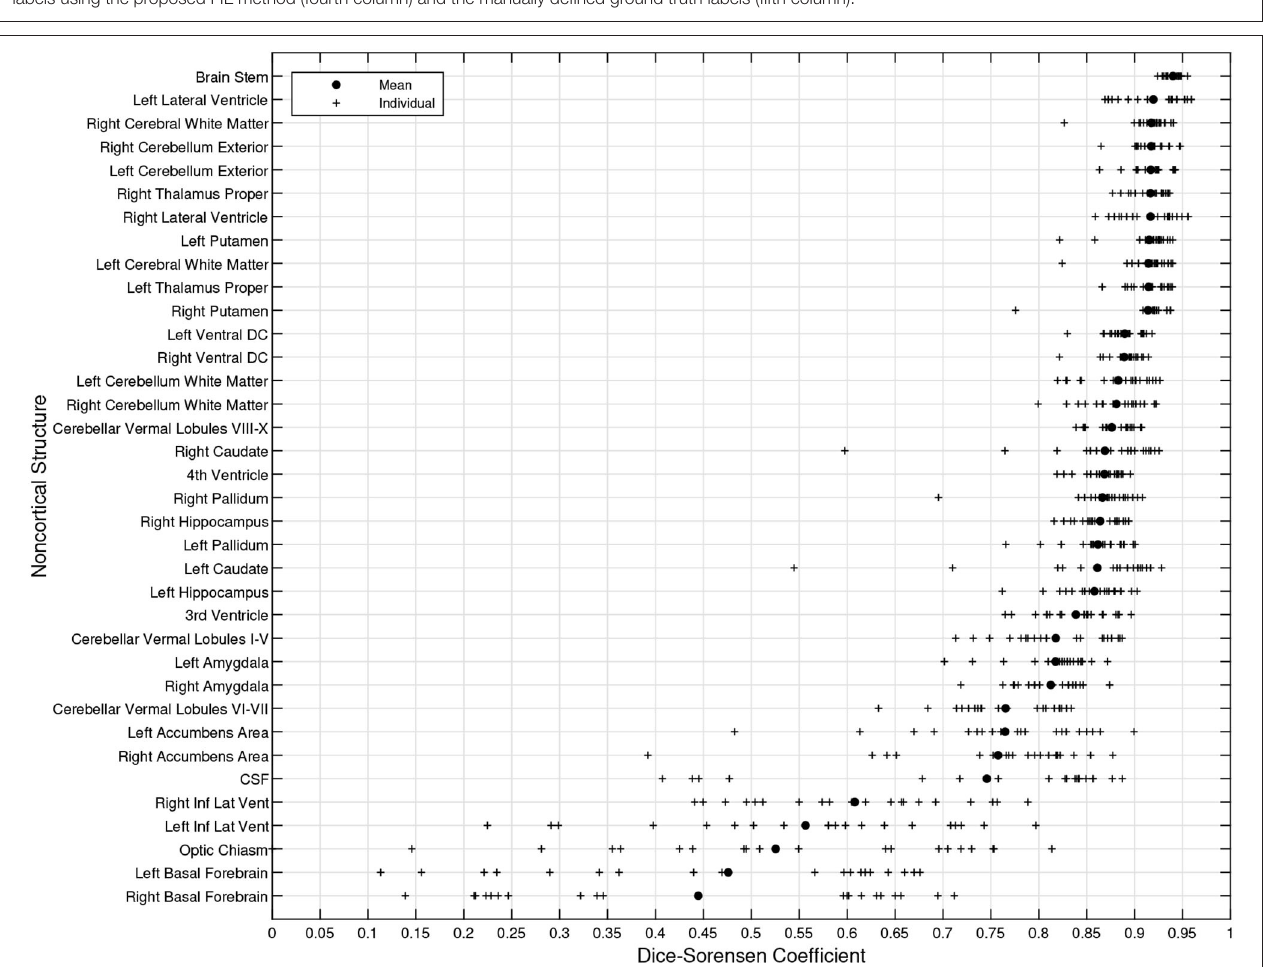
FIGURE 9 | DSC for non-cortical brain regions (fusion challenge data). Plots show individual DSC ( + ) as well as average DSC ( • ) across subjects for each brain region.